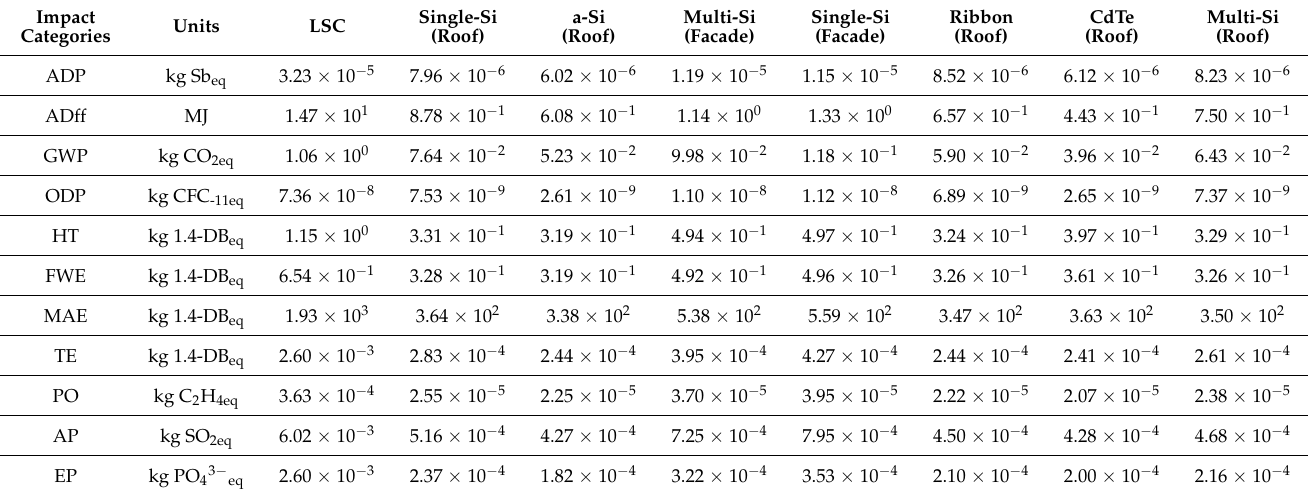
Table 5. Environmental impacts comparison between different PV modules (1